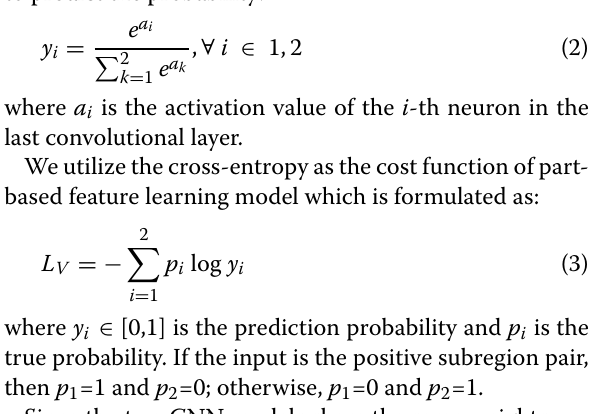
where f 1 , f 2 , and f s are the 2048 dimensional vectors for the ResNet-50 model.